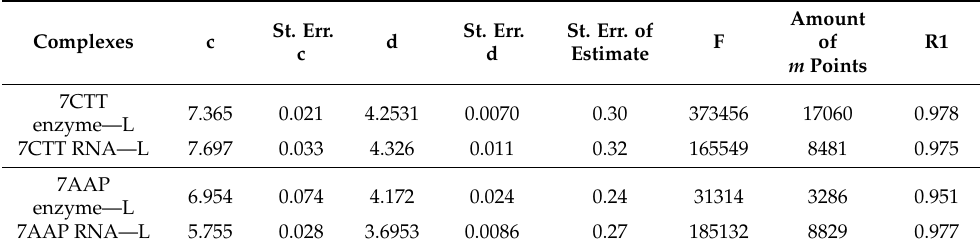
Table 2. Values of the c- and d-parameters, Standard Error for c- and d-parameters (St. Err.), Standard Errors of estimate, Fisher’s criterion (F-test), amount of m points and the correlation coefficient R1 for complexes 7CTT and